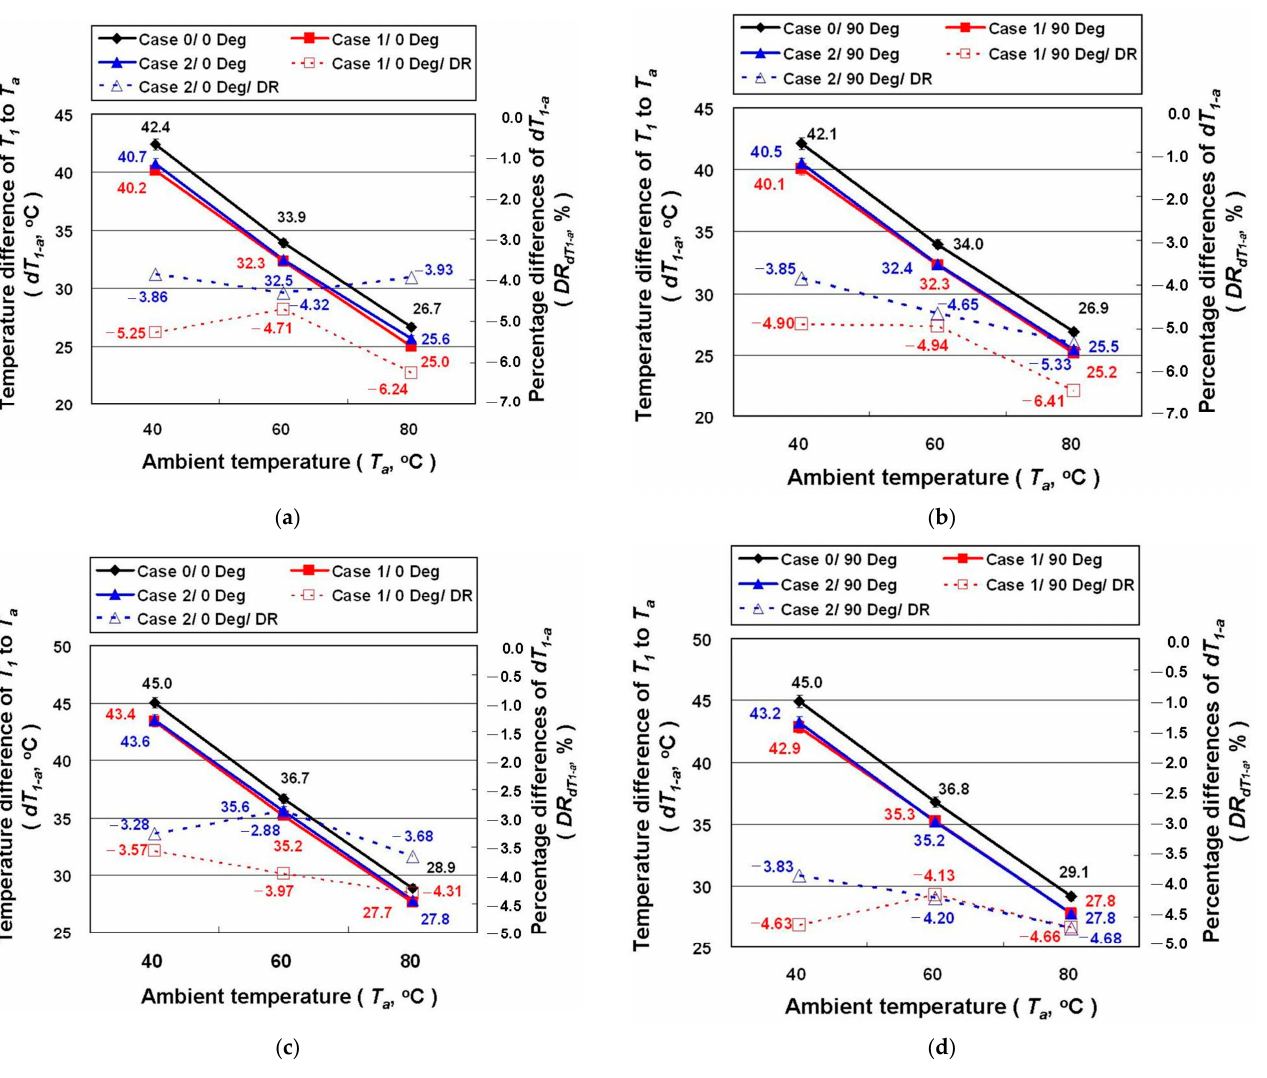
Figure 8. The dT 1-a and the DR dT 1-a of the LED lamps under different experimental parameters: ( a ) high beam/0 degrees; ( b ) high beam/90 degrees; ( c ) low beam/0 degrees; ( d ) low beam/90 degrees.